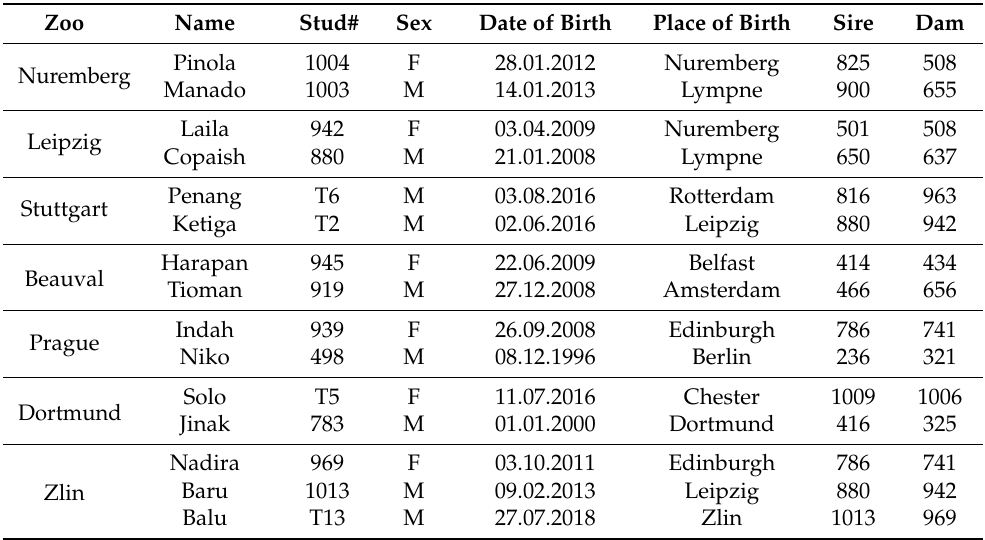
Table 1. The location, demographic data, and close kinship of all study subjects, Stud# is the individual EEP-studbook number